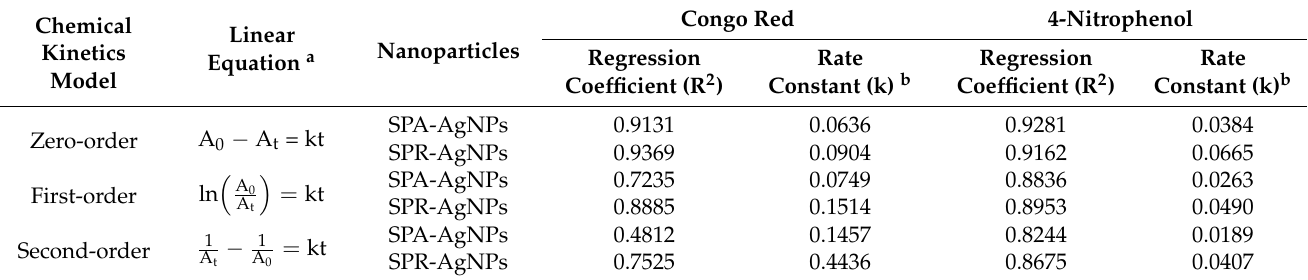
Table 4. The rate constant and regression coefficient (R 2 ) values of Congo Red and 4-nitrophenol degradation using different rate laws